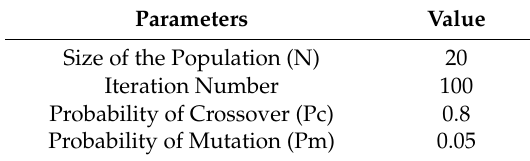
Table 3. Parameters for GA.